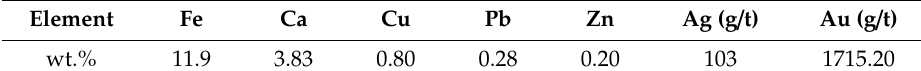
Table 1. Chemical composition of raw concentrate by atomic-absorption spectrophotometry (AAS) (wt.%) and lead-fire assay.